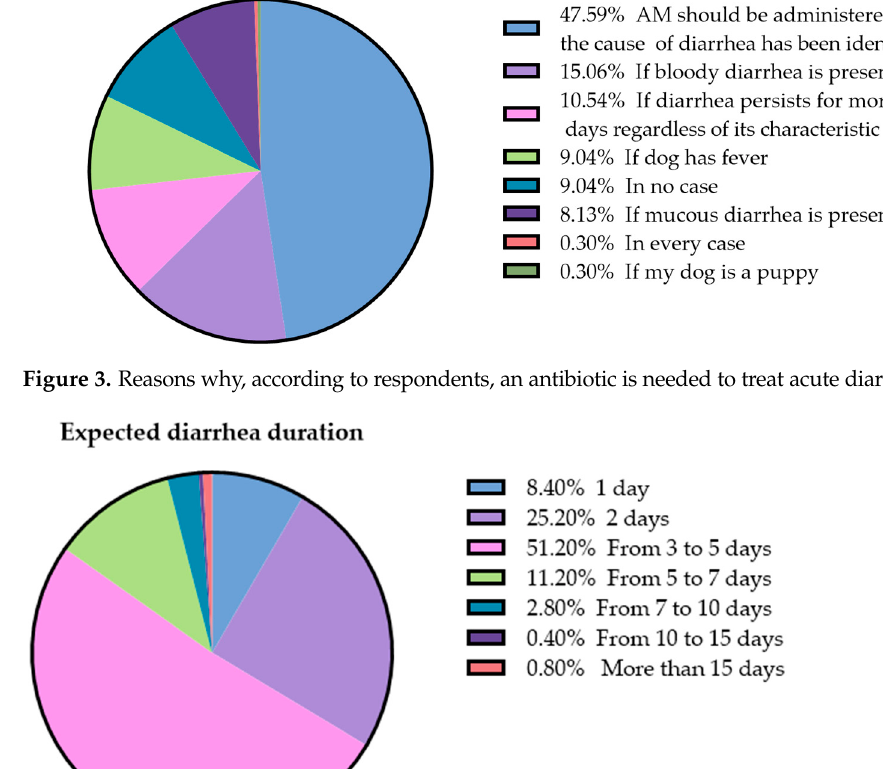
Figure 4. Expected acute diarrhea duration according to respondents.